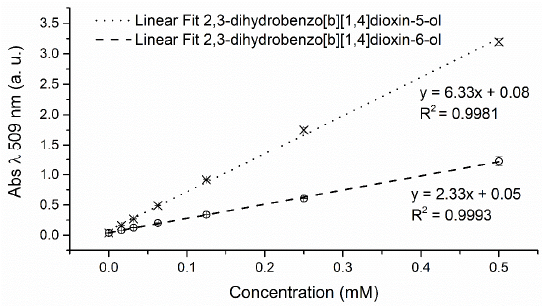
Figure A1. The 4-AAP linear detection range of 2,3-dihydrobenzo-1,4-dioxin-5-ol and 2,3-dihydrobenzo-1,4-dioxin-5-ol in a 96-well MTP